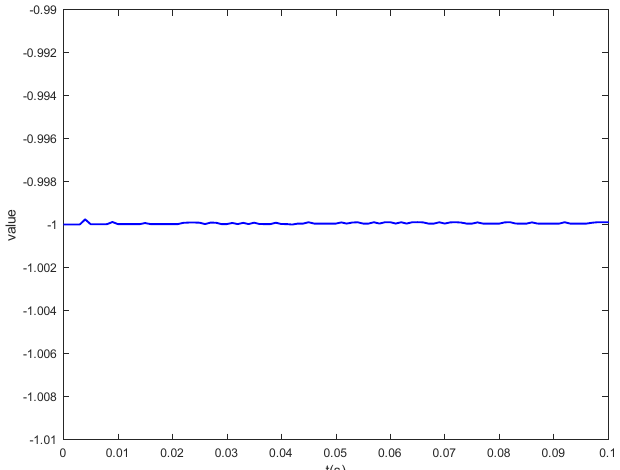
Figure 16. Characteristic parameter identification curve of f 2 ( k ) .